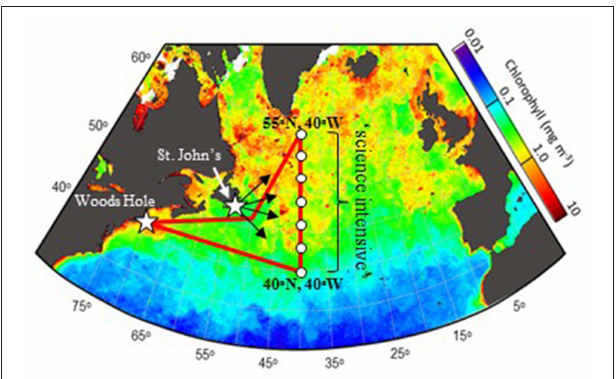
FIGURE 3 | NAAMES study region and nominal campaign plan. Red line = ship track. White circles = ship stations. White stars = Woods Hole, MA, USA and St. John’s, Newfoundland, Canada. Black arrows = aircraft flights heading toward “science intensive” region bound between 40 ◦ N and 55 ◦ N along 40 ◦ W longitude. Background color shows satellite-based surface chlorophyll concentrations for June 2002, exemplifying a typical